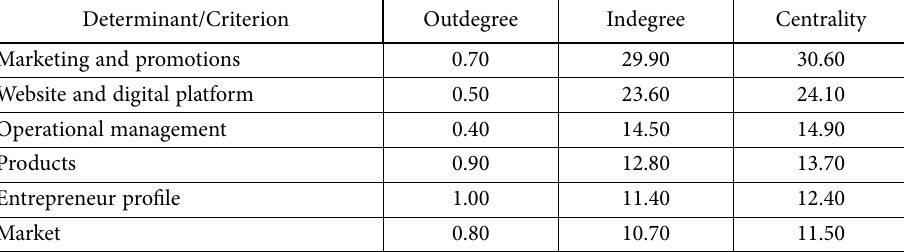
Table 3. Degree of centrality of determinants of SME